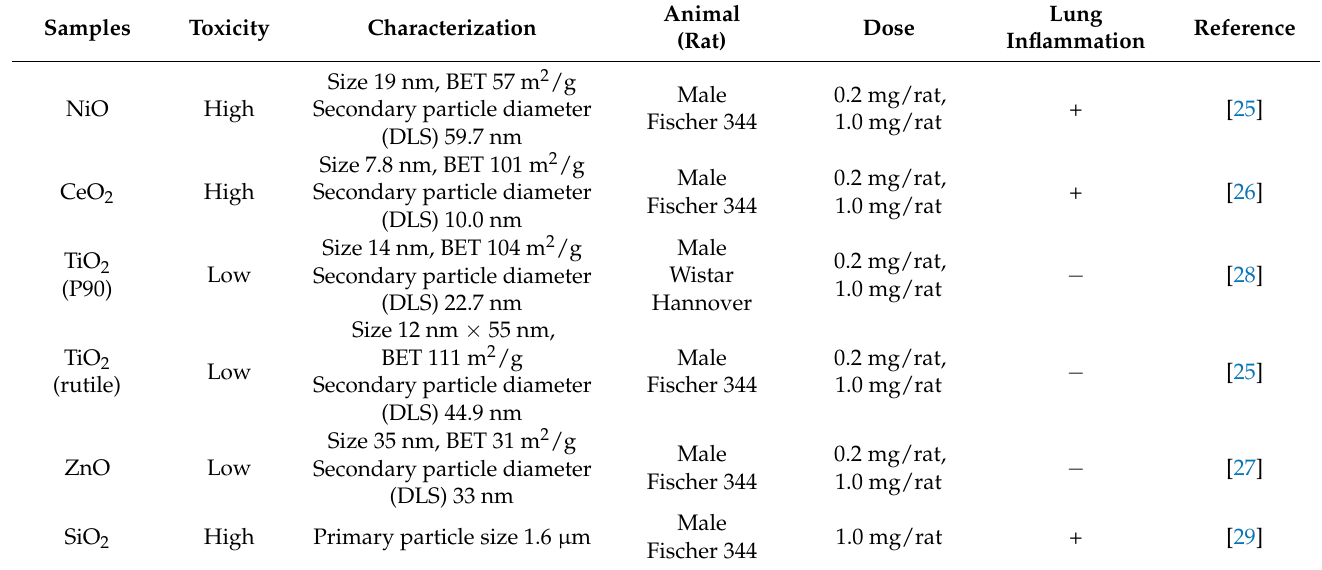
Table 3. Characterization of inhaled chemicals including